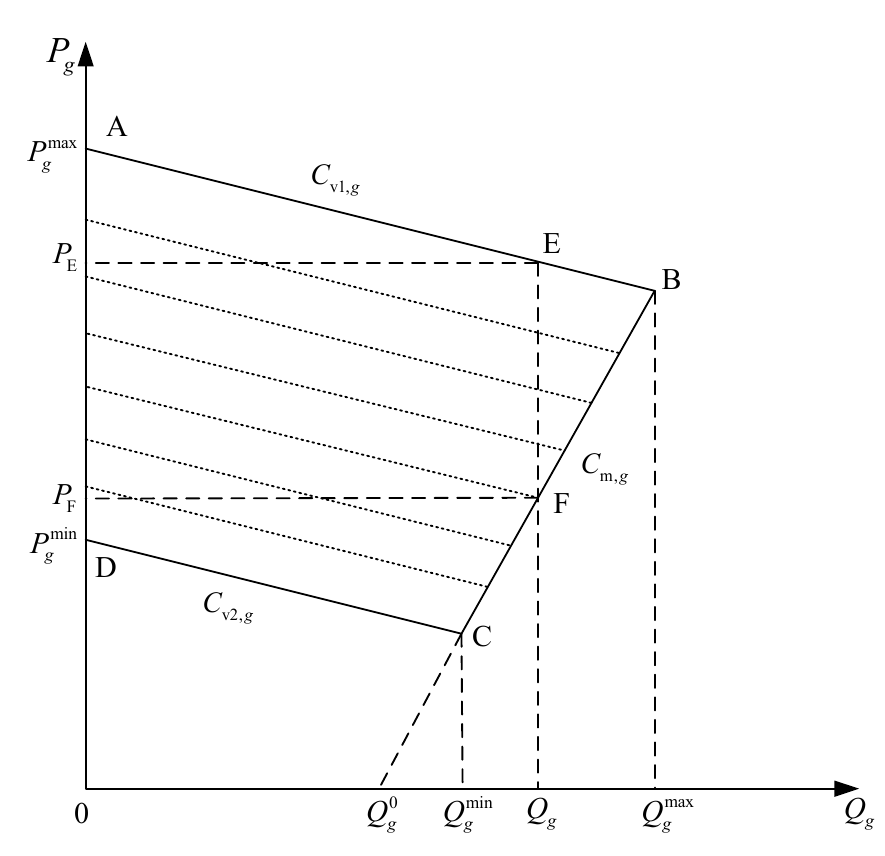
Figure 2. Electrical and heat power characteristics of CHP